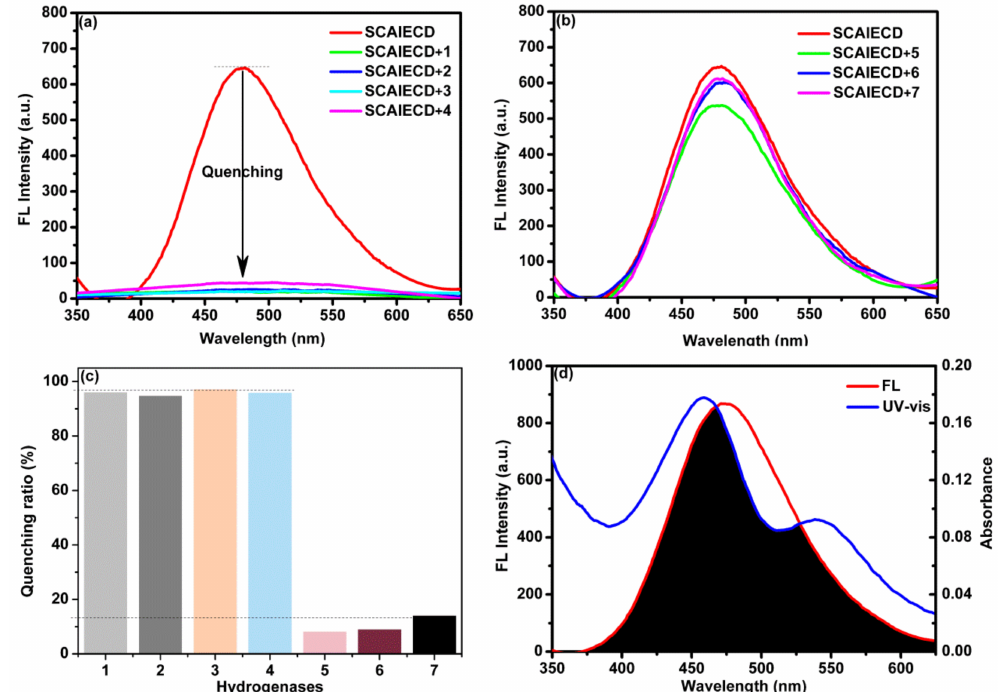
Figure 3. ( a , b ) Fluorescence emission spectra upon addition of hydrogenases (5 µ M) to a solution of SCAIECD (5 µ M); ( c ) Fluorescence quenching ratio upon addition of hydrogenases (5 µ M) to a solution of SCAIECD (5 µ M); and ( d ) fluorescence emission spectra of SCAIECD in DMSO/H 2 O (70/30, v / v ) and the UV-VIS of hydrogenase 1 .